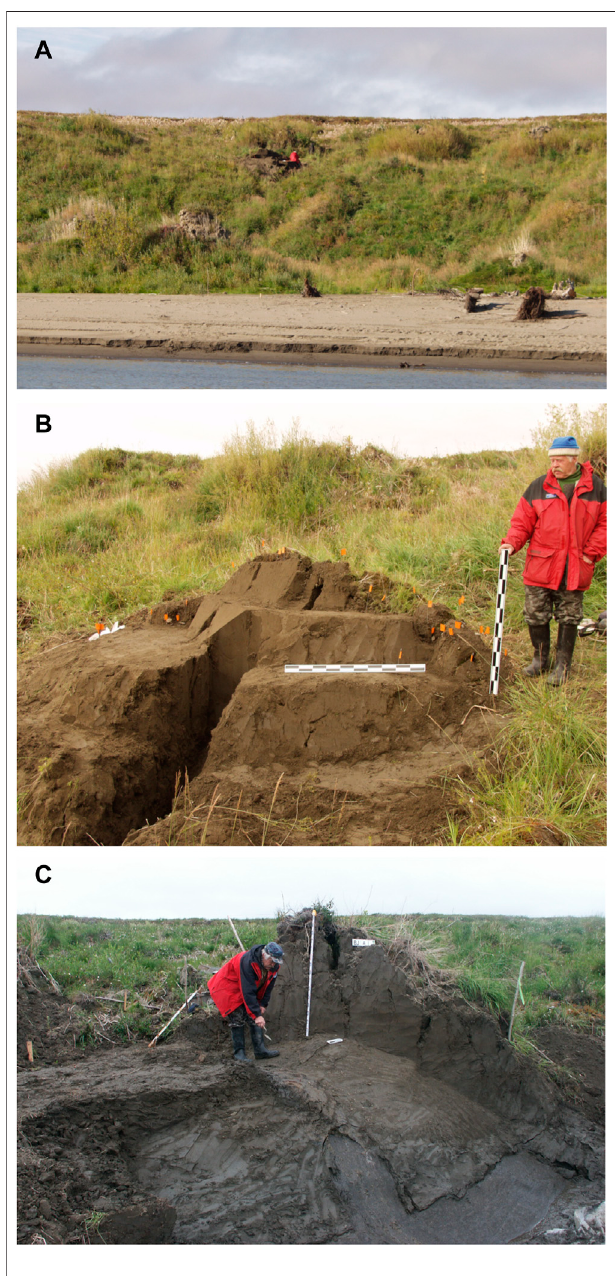
FIGURE 15 | Testing excavations in the Yana B area in 2003 and 2004: (A) leftbankoftheYanaRiverneartheYanaBareaoftheYanasitecomplexin 2004 viewed from the South; (B) – excavated upper part of the thermokarst mound with faunistic and lithic fi nds marked by the fl ags making a circle, view from the South; (C) excavated part of the thermokarst mound after fi nds taken away, view from the South-West; it appears to be artifact-free deposit while in fact there is a cultural layer in 7 m